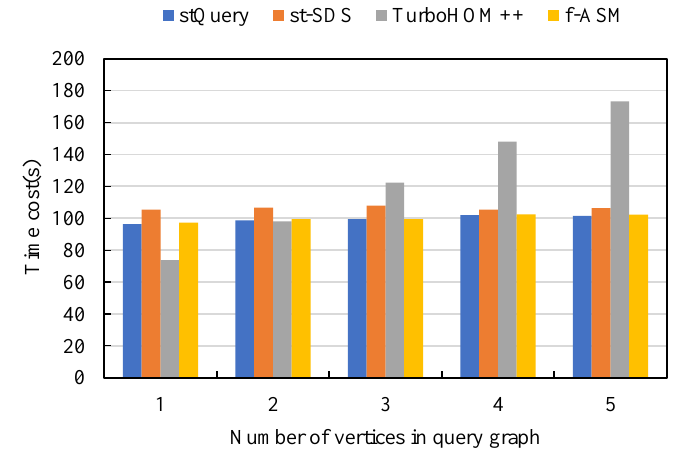
Figure 12. Experimental comparison of the loop query pattern.